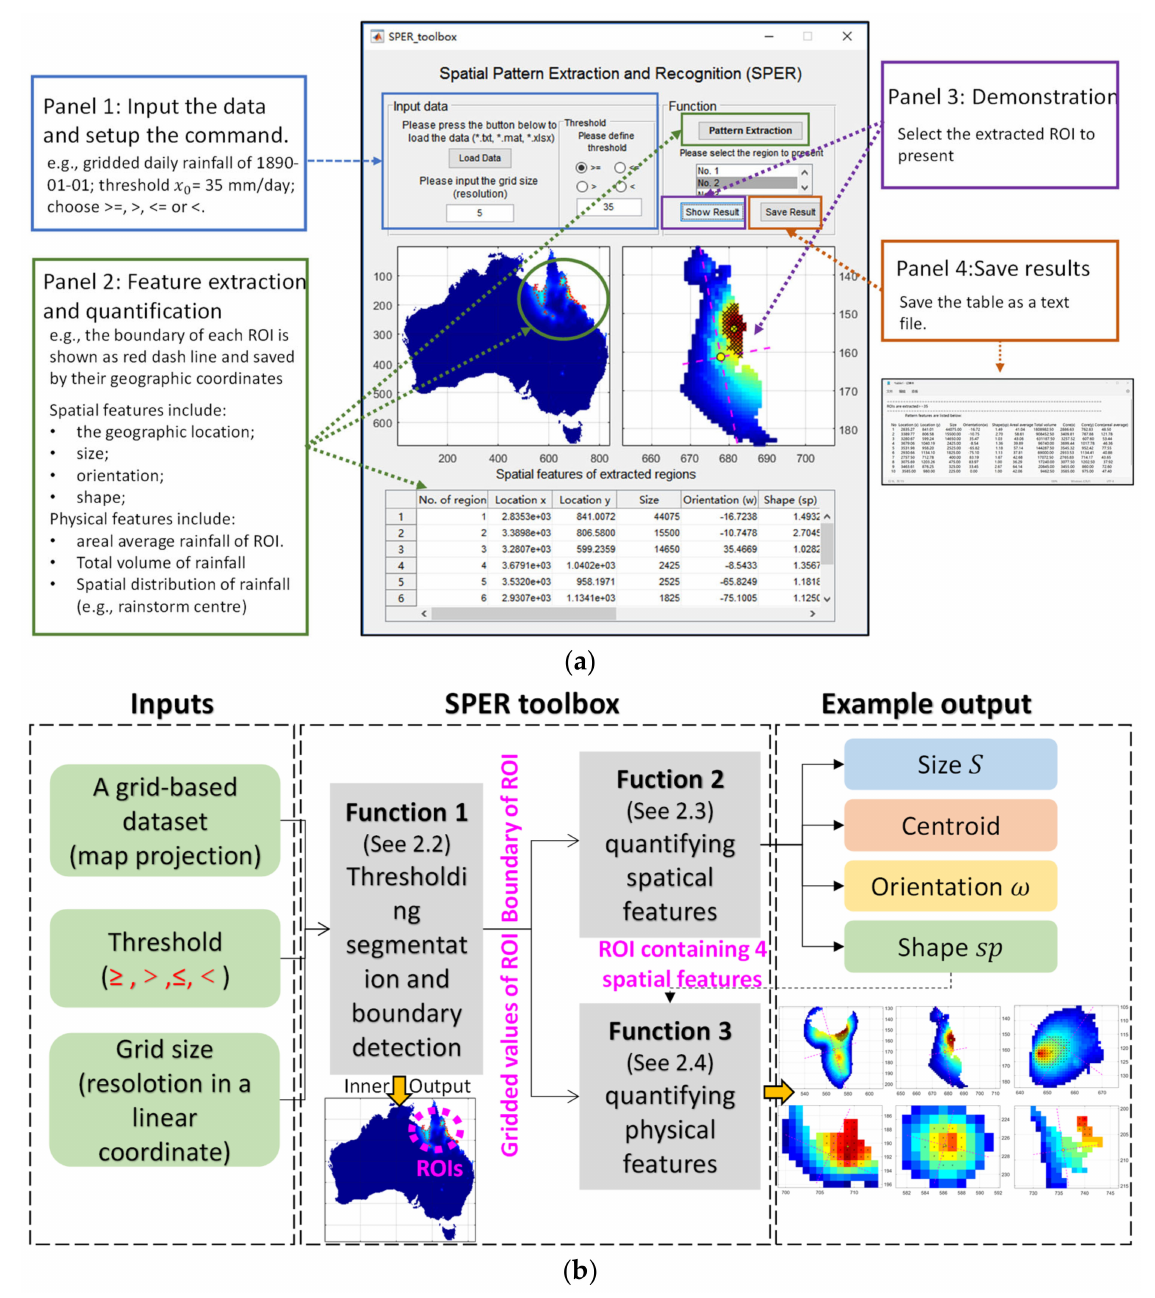
Figure 1. ( a ) The interface of the Spatial Pattern Extraction and Recognition (SPER) toolbox; ( b ) the structure, inputs, example output of the